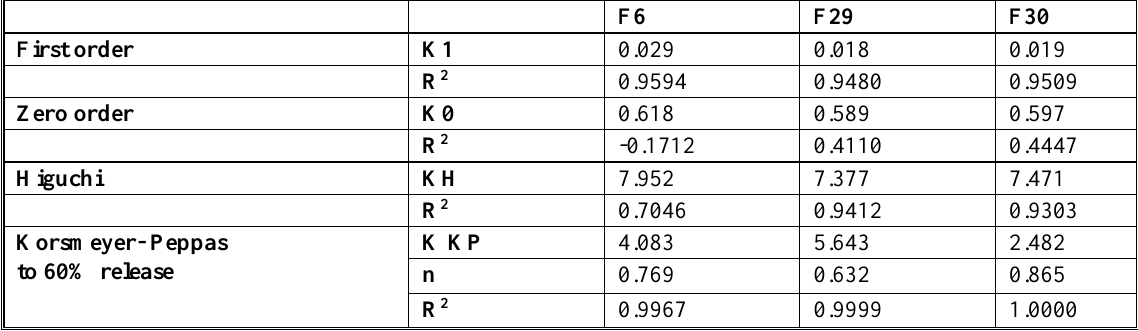
Table 3.Mathematical release kinetics of secnidazole from oral in-situ gel .